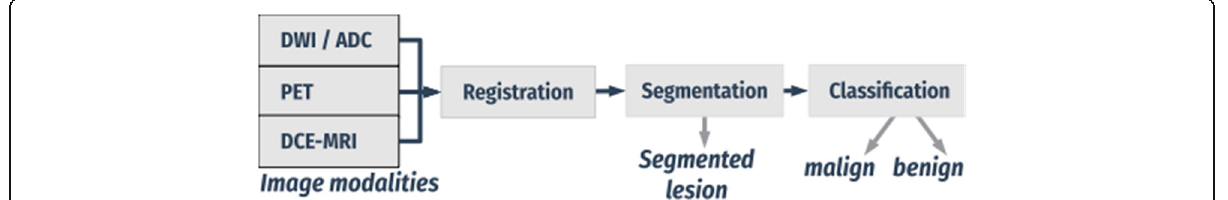
Fig. 2 Overview of the CAD pipeline based on multimodal and mpI